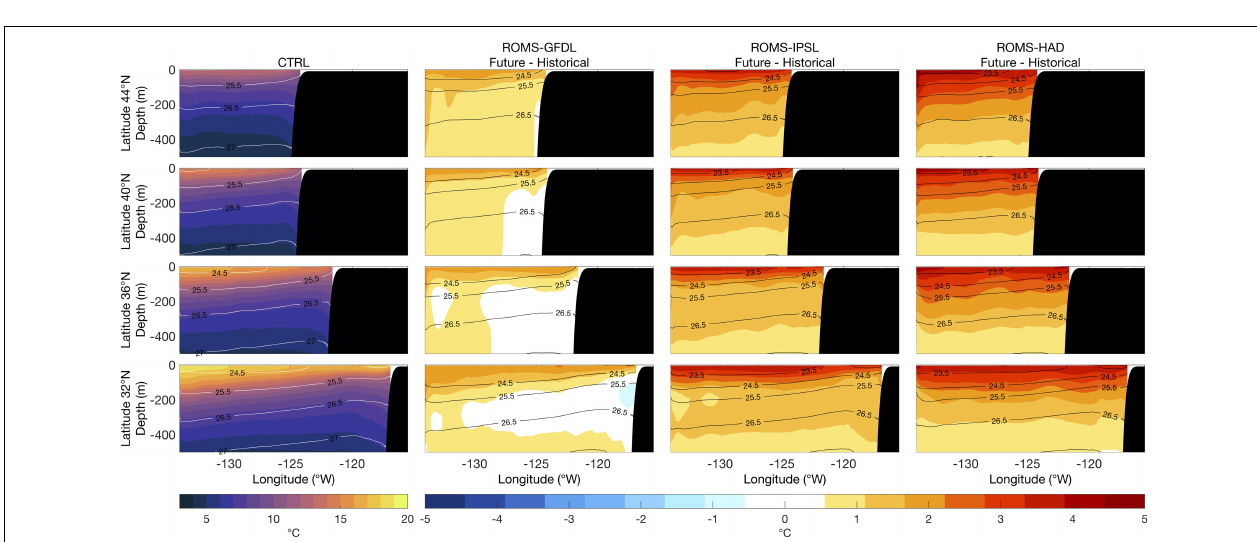
FIGURE 5 | Vertical sections of mean temperature (1980–2010) from the control run (CTRL, first column) and of future temperature changes (2070–2100 relative to historical) from the high-resolution downscaled projections: ROMS-GFDL (second column), ROMS-IPSL (third column), and ROMS-HAD (fourth column). Black contours are potential density (kg m − 3 ) relative to sea